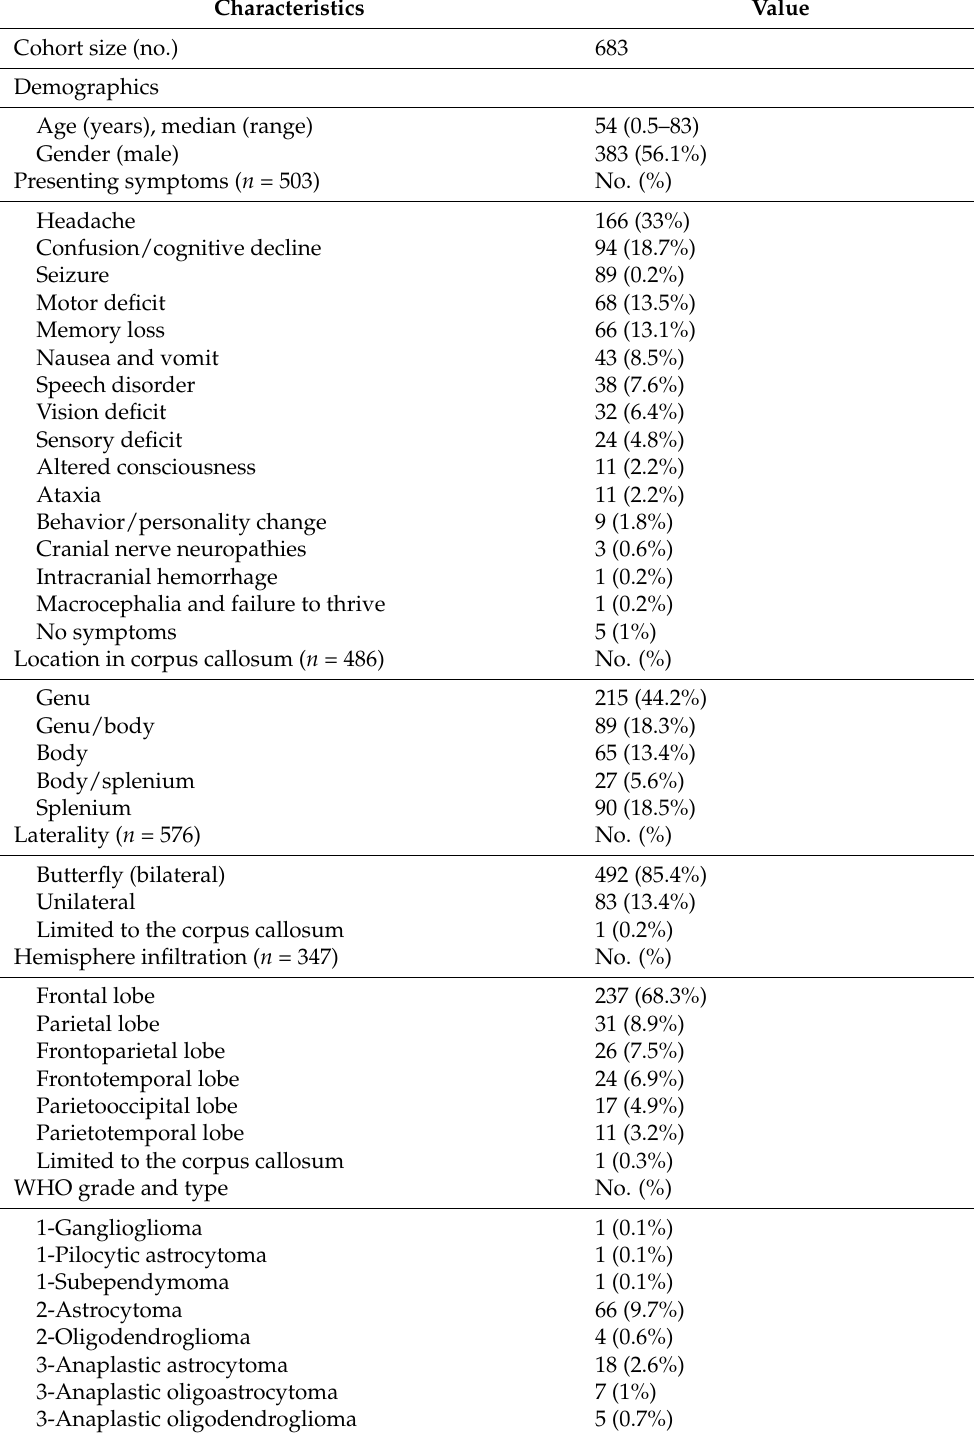
Table 1. Summary of clinicoradiological and histomolecular features of all pooled